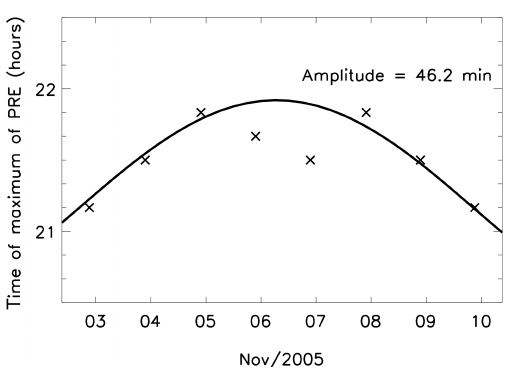
Figure 3. Same as Fig. 2 but for the time of the maximum of the vertical drift of the F